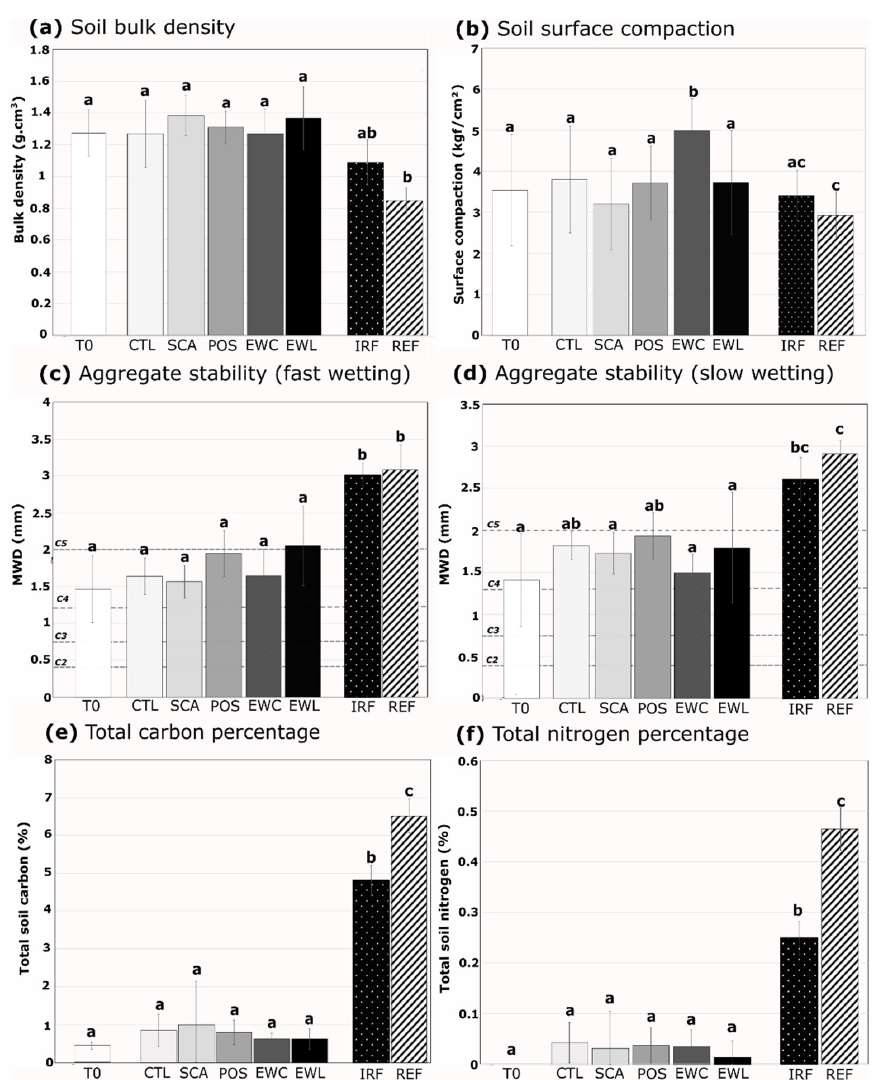
Figure 4. Soil characteristics (mean ± SD) of the sampling points at T0 and plots at T + 1 year. ( a ) Soil bulk density; ( b ) soil surface compaction; ( c , d ) stability of soil aggregates during ( c ) fast wetting and ( d ) slow wetting [67]. Mean weight diameter (MWD) corresponds to the post-treatment size of the lasting aggregates; classes of soil stability range from unstable (C2) to strongly stable (C4) (see [67]); ( e ) soil total carbon content; ( f ) soil total nitrogen content. Different letters above the bars (a–c) indicate significantly different values at a 95% level of significance according to the Kruskal–Wallis or ANOVA test. See the section 2.2. for soil restoration technique abbreviations.